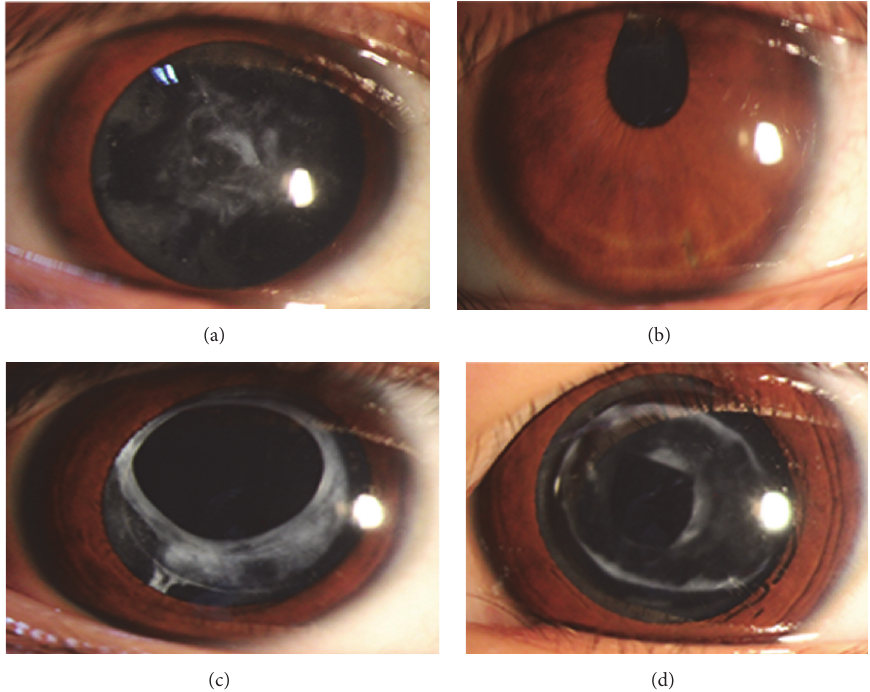
Figure 2: Slit-lamp photographs of the proband (III:5) and the proband’s son (IV:1) in both eyes. The images (a) and (b) represent the left and right eyes of III:5, respectively. The images (c) and (d) correspond to left and right eyes of